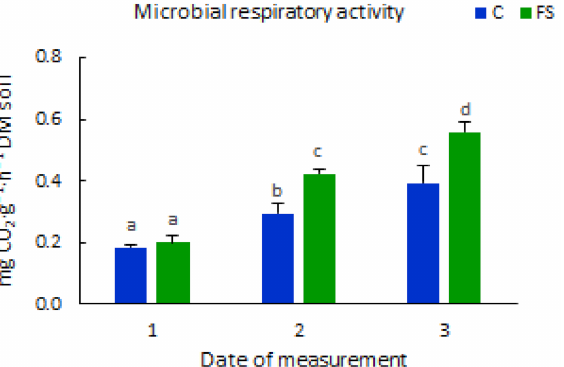
Figure 6. Microbial respiration in soil after fertilisation. Different letters above the error bars (i.e., ± SD) indicate significant differences ( p < 0.05) between means (Tukey post-hoc